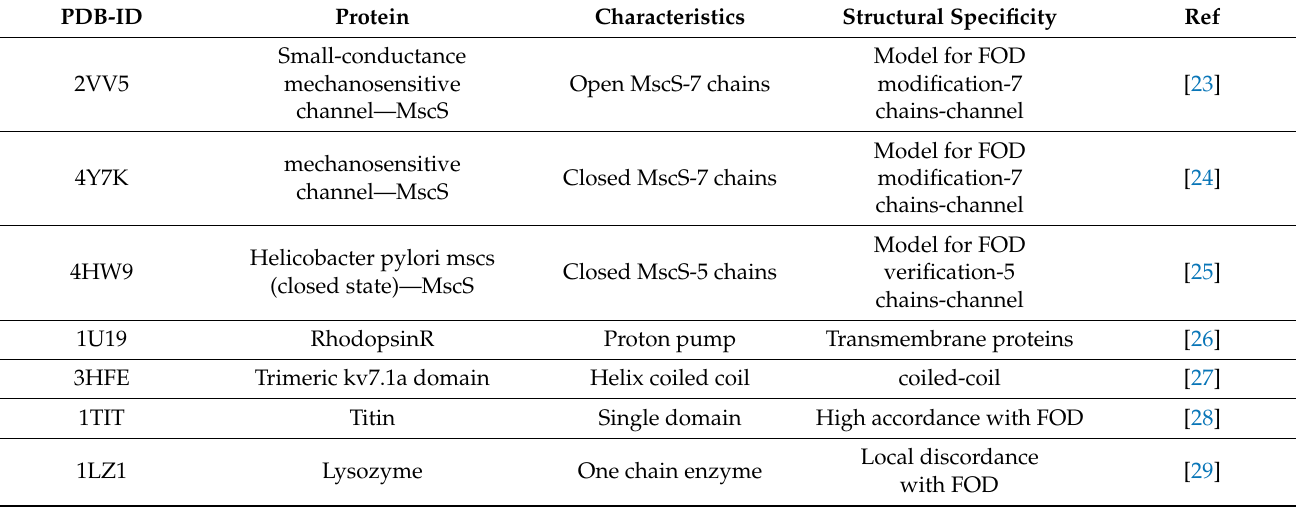
Table 4. The set of proteins discussed in the present work. A brief description and reasons for presence in the presented analysis are